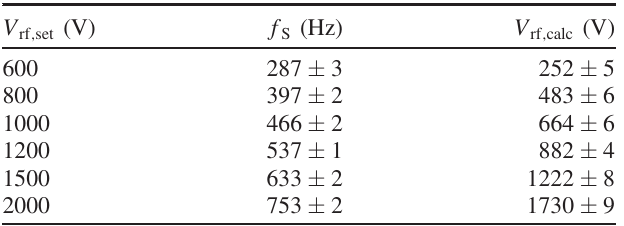
TABLE II. rf voltage derived from the measured synchrotron frequency.